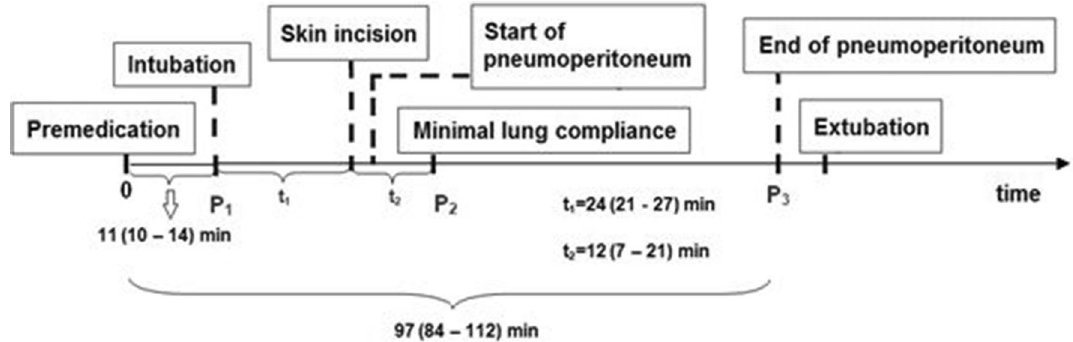
Figure 2. Study diagram showing key points of the operation: P 1 , P 2 , P 3 . The hemodynamic and respiratory parameters observed at these points were analyzed. Time data are expressed as the median and the range between the first and third quartile: Me (Q 1 –Q 3